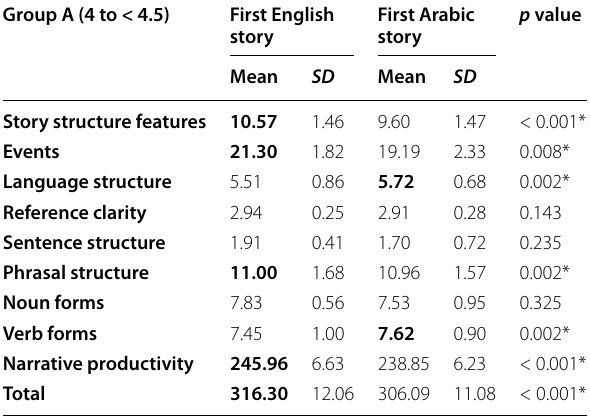
Table 11 Comparison between the two age groups regarding